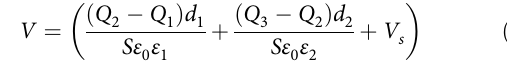
difference of charge quantity ( Q 2 – Q 1 ) and ( Q 3 – Q 2 ), and inversely proportional to relative dielectric constants of GO ( ε 2 ) and grGO ( ε 1 ). Firstly, the average surface potential of a single GO and grGO sheet is about − 2 mV and − 27 mV (EFM results in Fig. 5b,